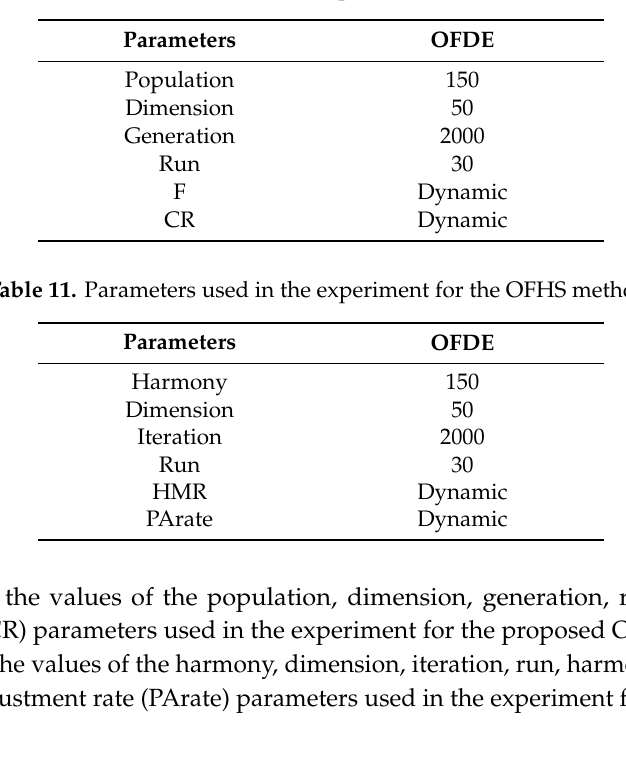
Table 10. Parameters used in the experiment for the OFDE method.